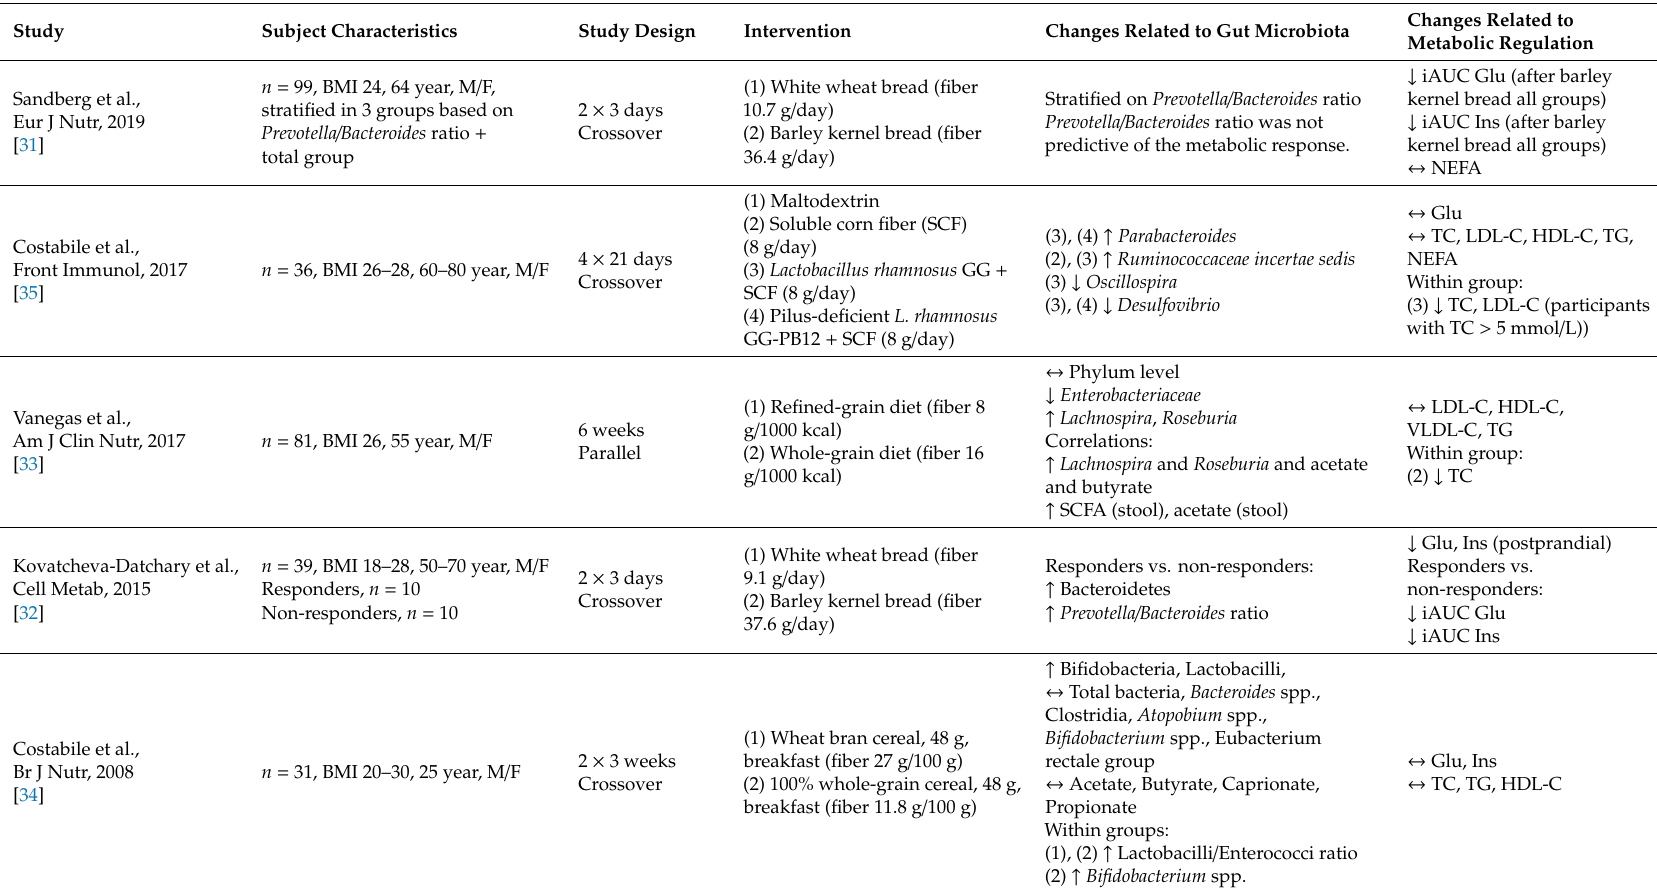
Table 2. Fiber, gut microbiota, and metabolic regulation in healthy individuals. Significant results are indicated by an up / down